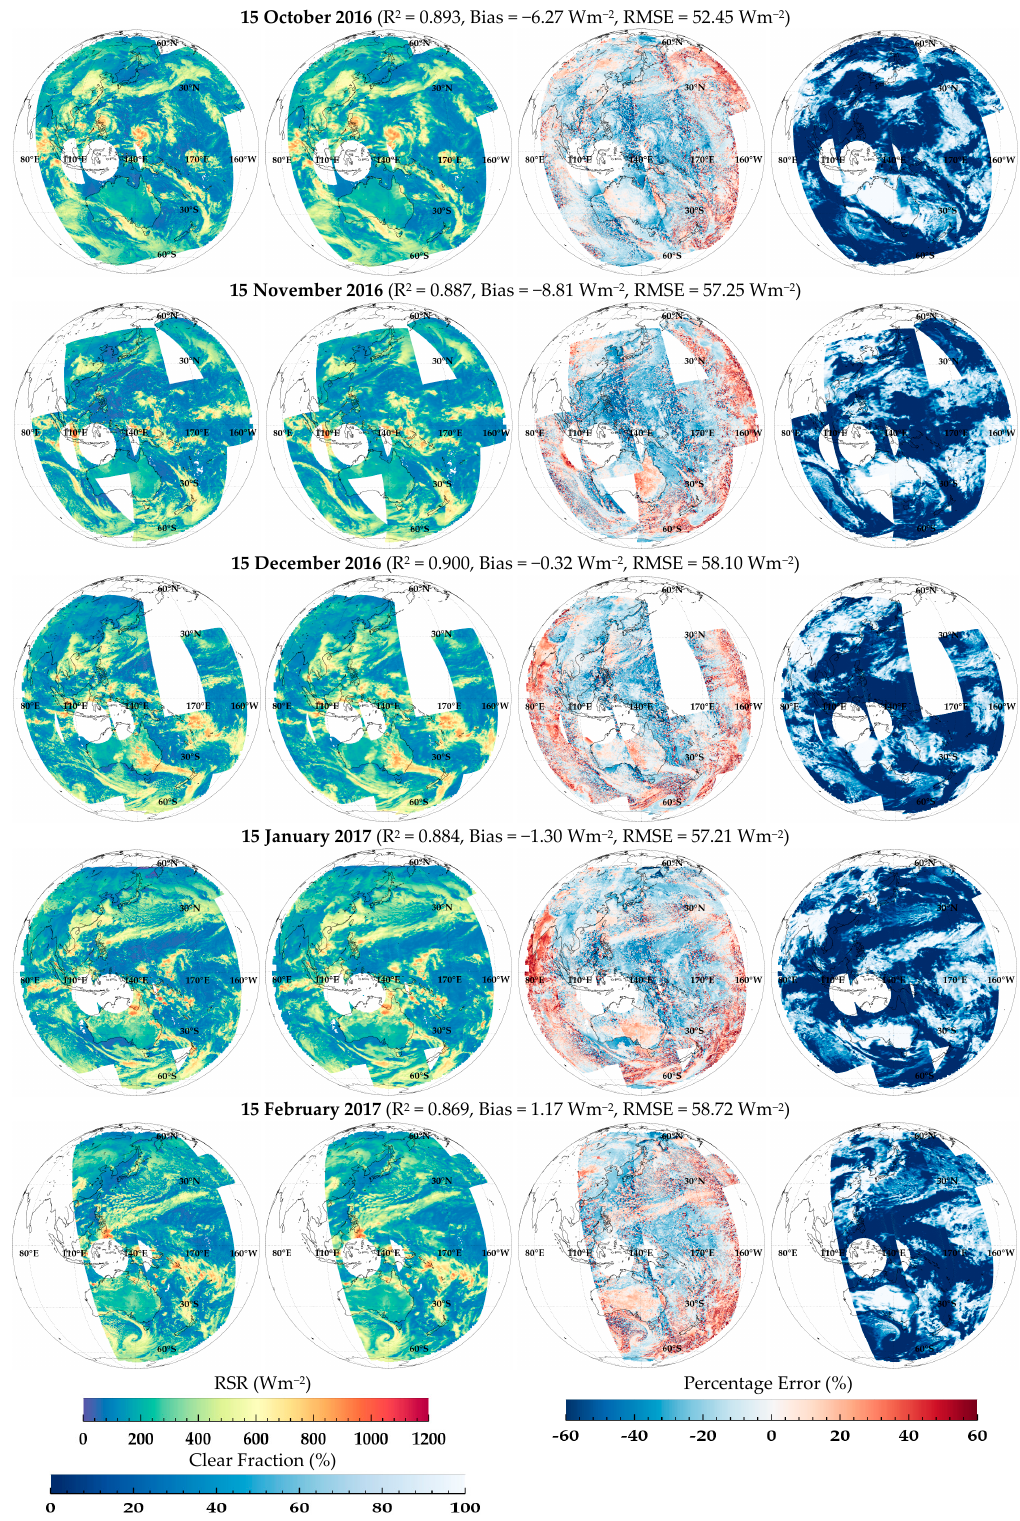
Figure 10. RSR (Wm − 2 ) of Himwari-8/AHI ( left ) and S-NPP/CERES ( middle left ) retrieved using data from the 15th day of every month between July 2015 and February 2017; percentage error (%) ( middle right ) and clear fraction (%) ( right ) between Himawari-8/AHI and S-NPP/CERES data sets; R 2 , Bias, and RMSE (top) between the two data sets.